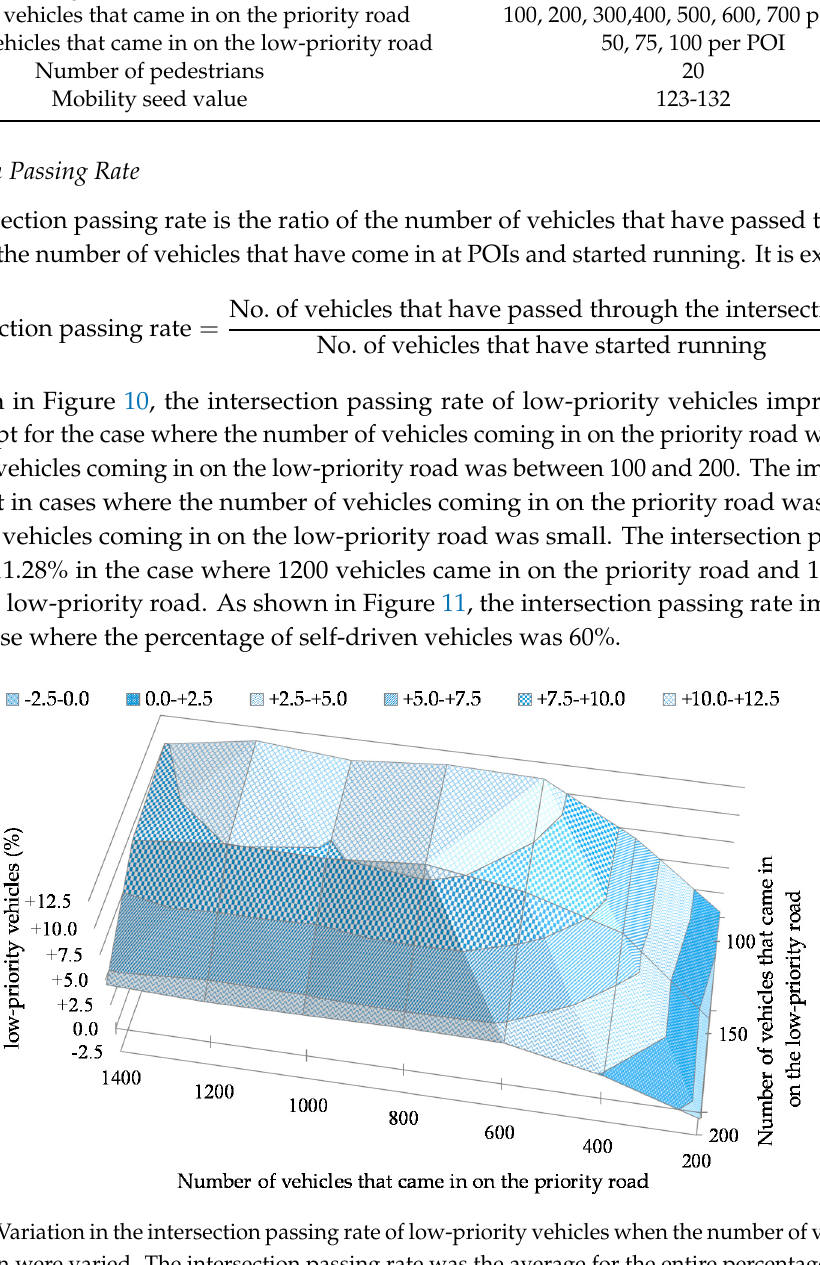
Table 7. Simulation conditions.